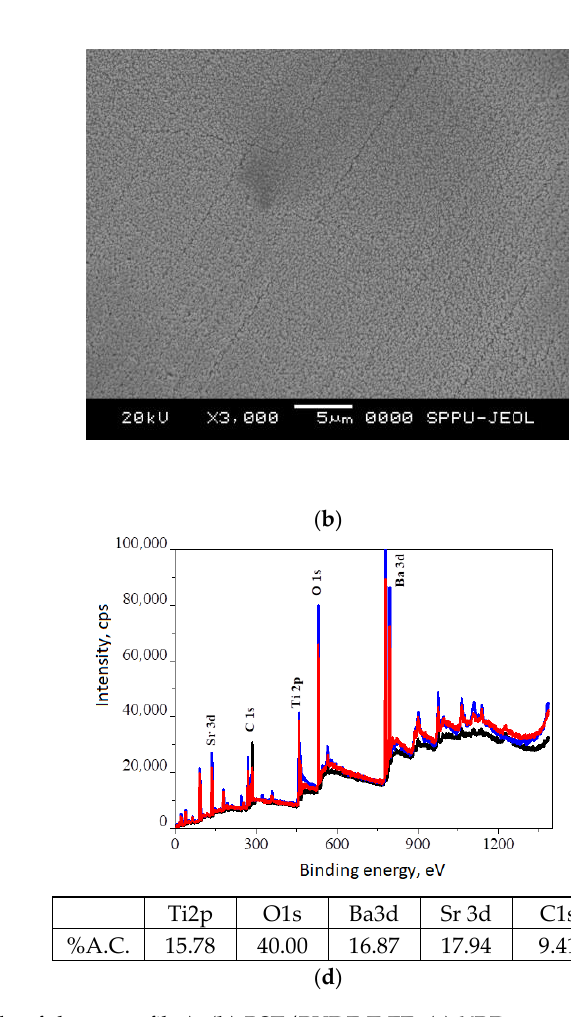
Figure 2. SEM images of ( a ) BST (the inset is smaller scale of the same film); ( b ) BST/PVDF-TrFE; ( c ) XRD patterns of BST films grown at different sputtering voltages and ( d ) XPS analysis of BST sputtered at 0.75 kV and extracted atomic concentration of the elements in percent.